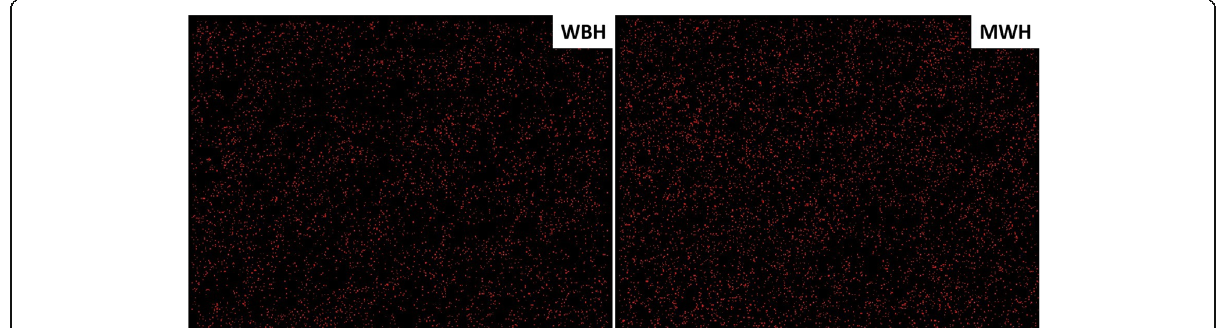
Fig. 8 The aluminum distribution in tanned skin pieces by EDX under different heating methods